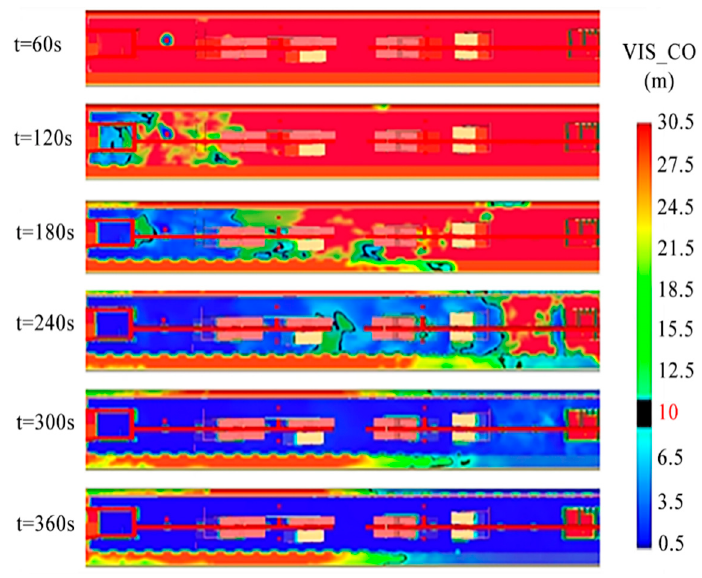
Figure 8. Visibility in the fire at the end of the platform.